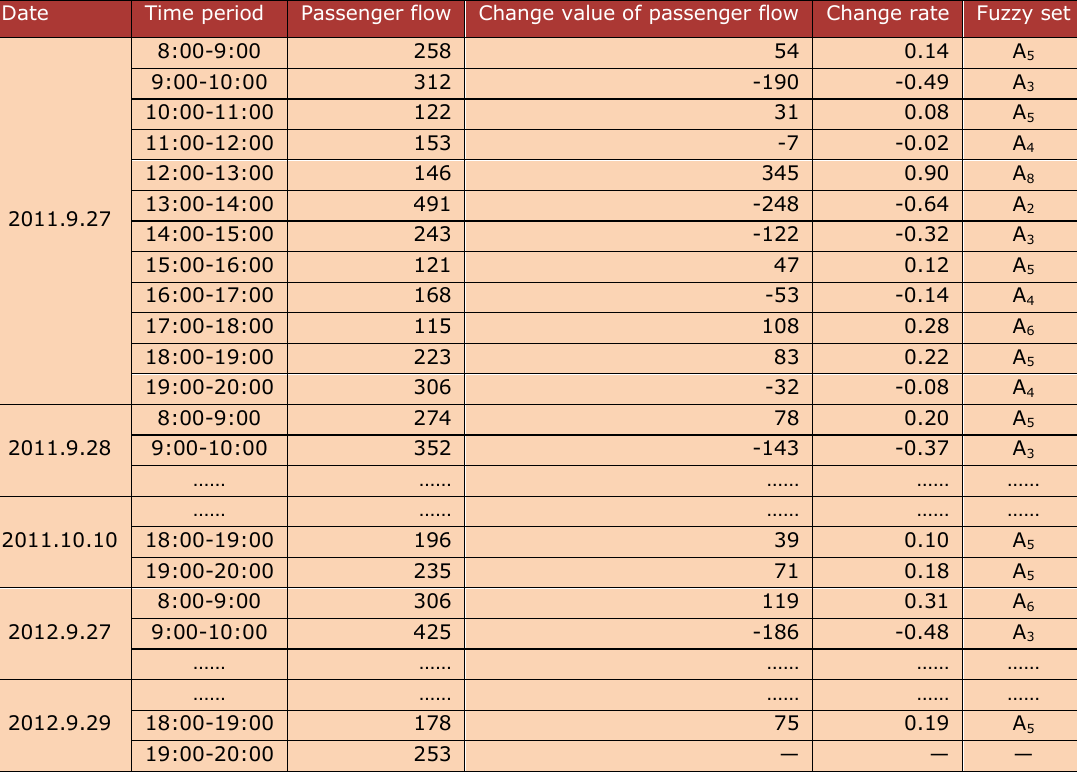
Table 4. Information of the historical passenger flow data